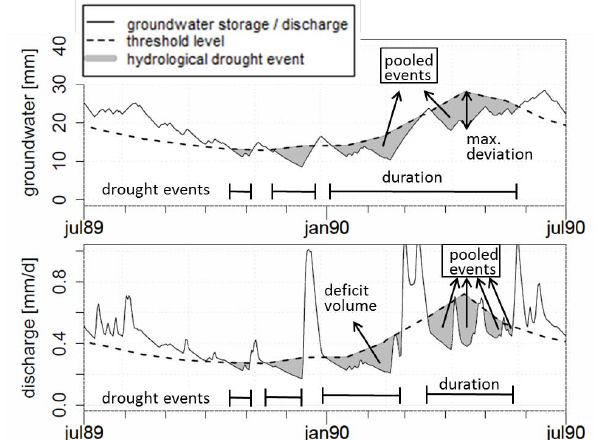
Fig. 4. Threshold level method with variable threshold (80th per- centile of monthly duration curve, smoothed by 30-day moving av- erage) for groundwater storage (upper panel) and discharge (lower panel), including an illustration of pooling method and drought characteristics duration, deficit volume, and maximum